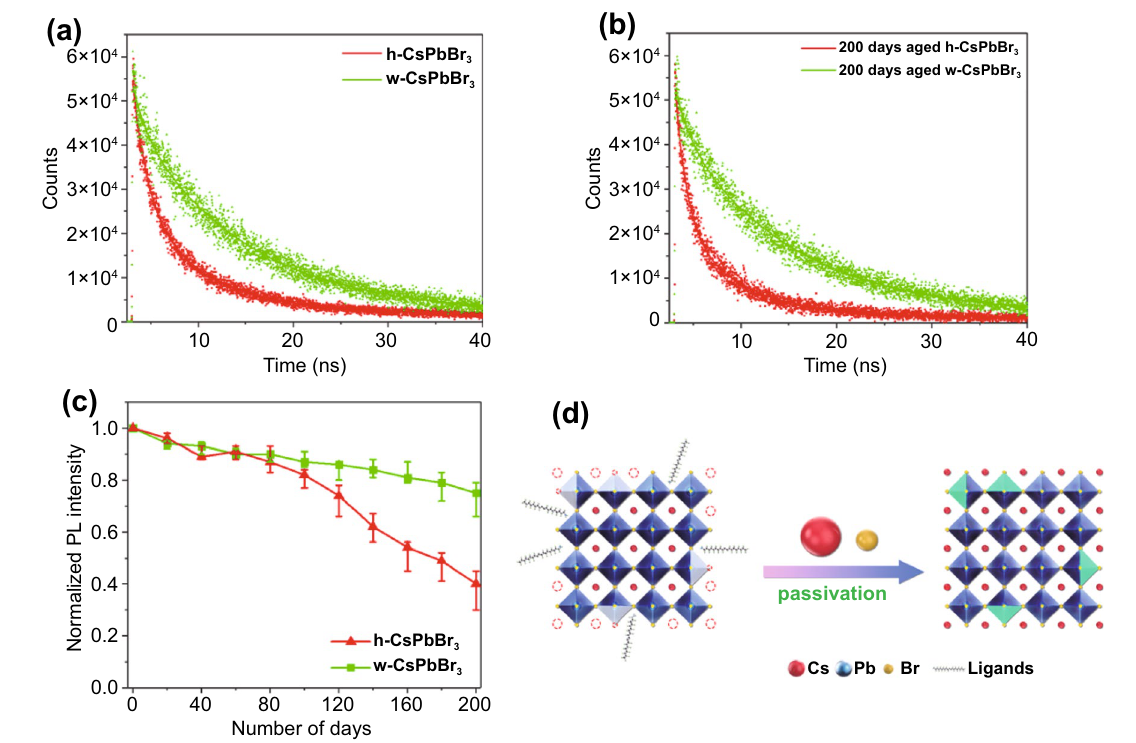
Fig. 3 TRPL spectra of freshly prepared ( a ) and 200 days aged ( b ) h‑CsPbBr 3 and w‑CsPbBr 3 NCs, respectively; c PL stabilities of h‑CsPbBr 3 and w‑CsPbBr 3 NCs; d schematic of the surface passivation of CsPbBr 3